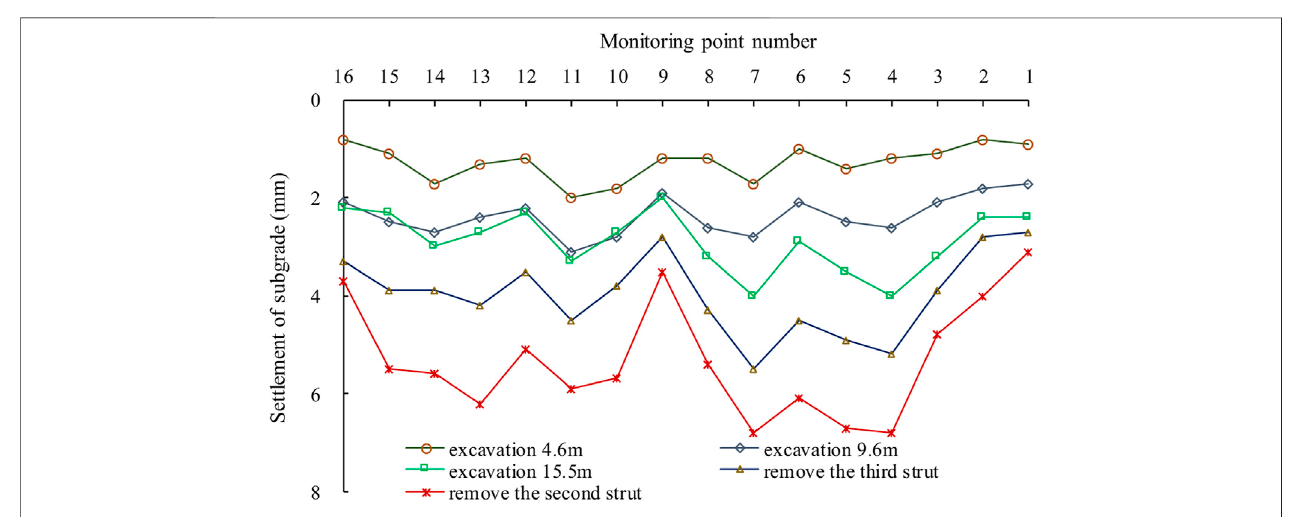
FIGURE 11 | Subgrade settlement changes in longitudinal